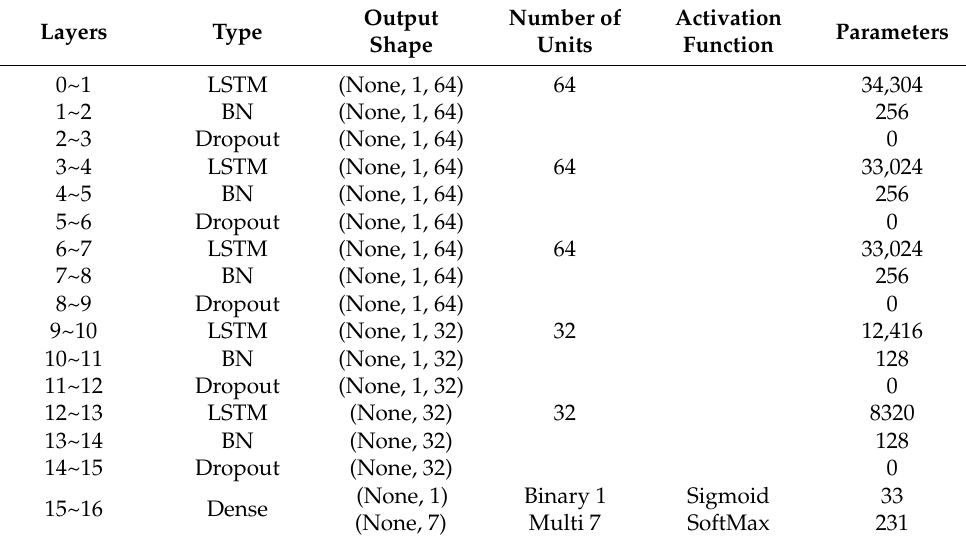
Table 13. LSTM-5-256 (5 layers and 256